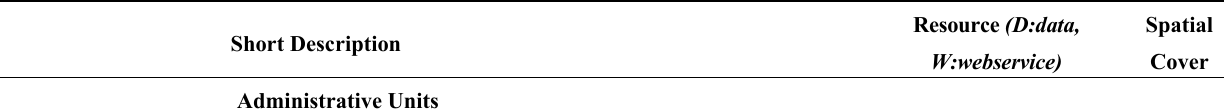
Table 3. Datasets for Analytical Environmental